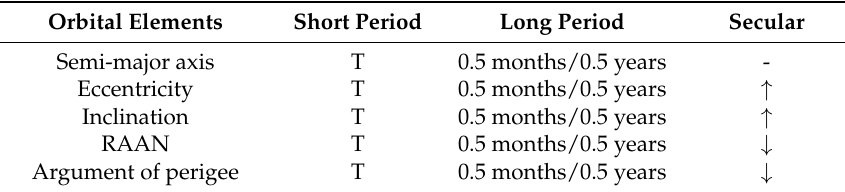
Table 3. Law of the GEO SAR orbital elements’ variations under the influences of the third body perturbations.